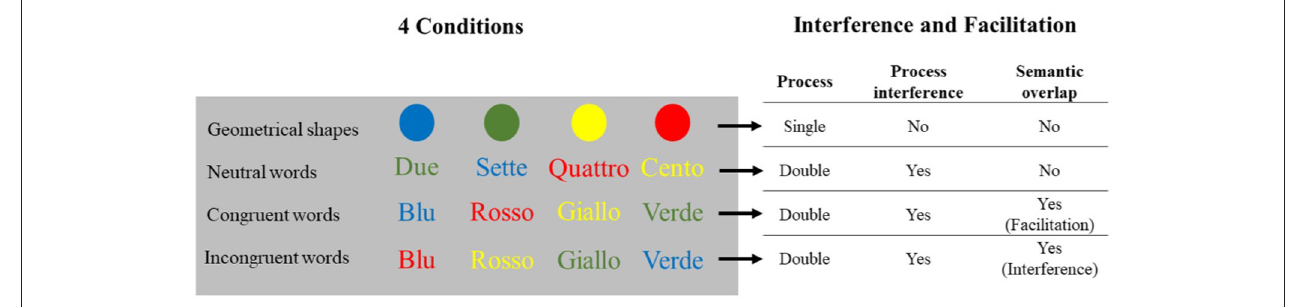
FIGURE 1 | Graphic representation of the four categories of stimuli coupled with the specific interferences and facilitations.